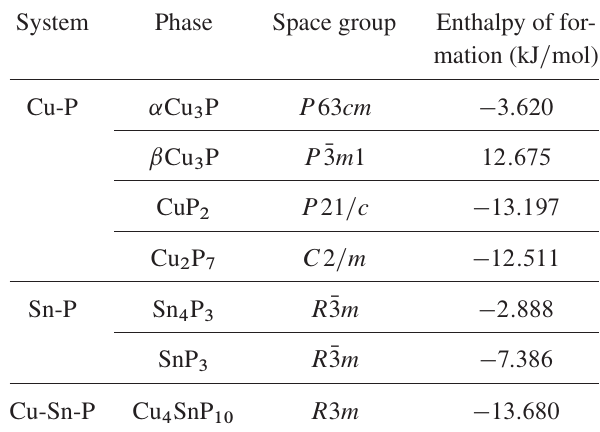
Table 2. The enthalpy of formation for binary compounds in the Cu-P, Sn-P and Cu-Sn-P systems at 0 K using first- principles